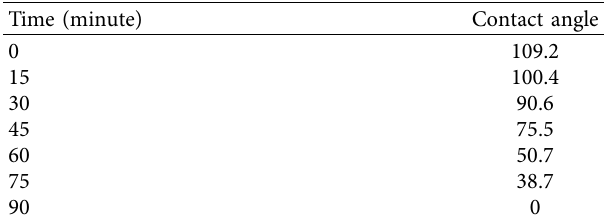
Table 3: Te contact angle of PVB/bentonite nanofbers versus the operating time.